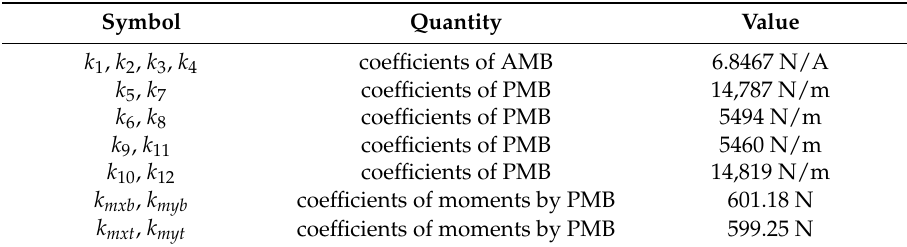
Table 3. Parameters of approximate magnetic